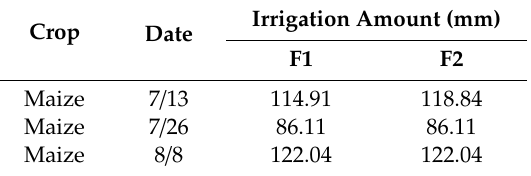
Table 1. Irrigation date and amount in Fenzidi in